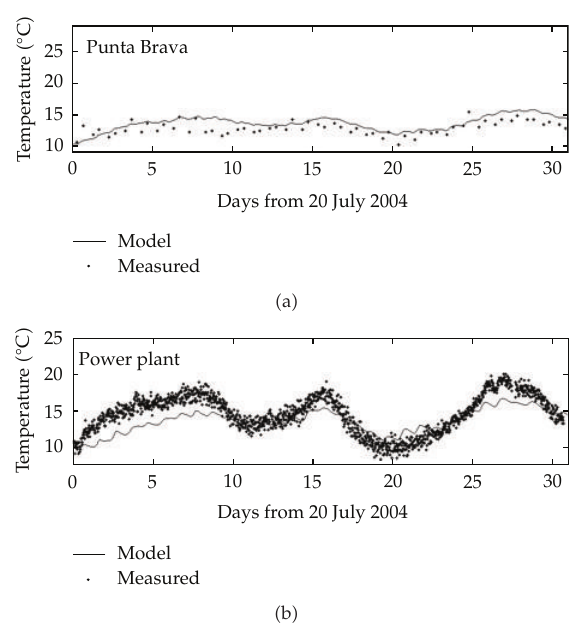
Figure 8: Comparison of the measured and modeled water temperature in Punta Brava and power plant station in July 2004.